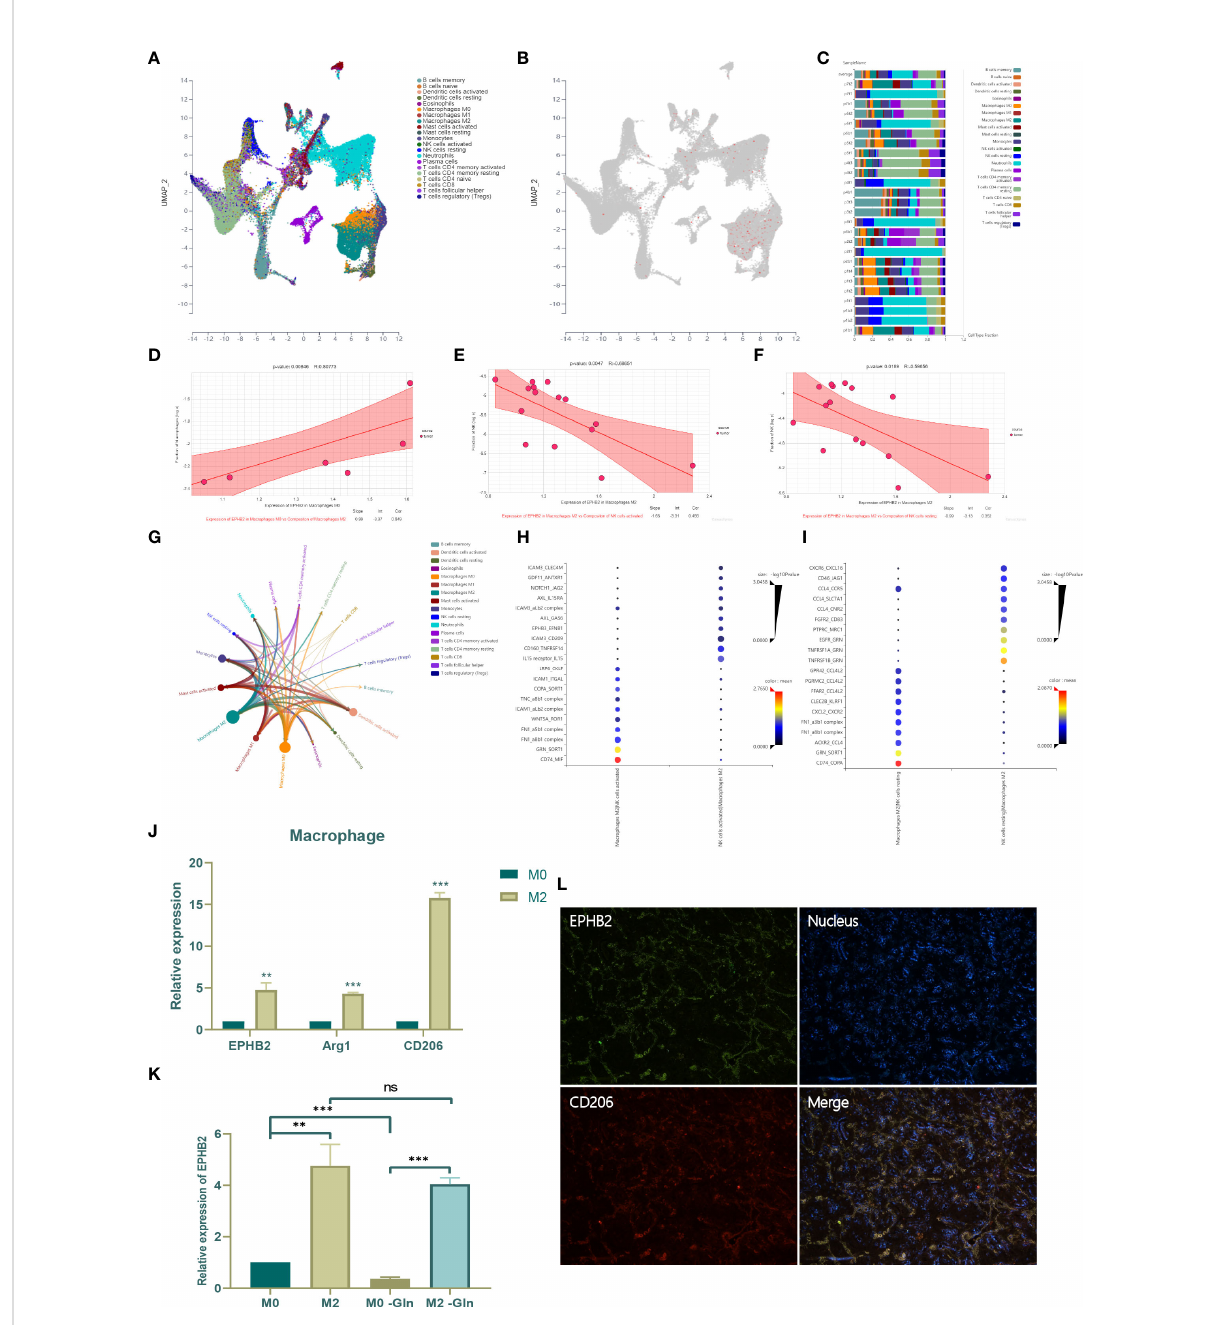
FIGURE 14 Effect of EPHB2 on in fi ltrating immune cells of TME. (A) The distribution of immune cell clusters in UMAP plot. (B) The expression of EPHB2 in distinct clusters of immune cells. (C) Cell type fraction of each sample. (D) Correlation analysis between expression of EPHB2 in macrophages M0 and composition of in fi ltrating macrophages M2. Correlation analysis between expression of EPHB2 in macrophages M2 and composition of in fi ltrating activated NK cells (E) and resting NK cells (F) . (G) Correlation network between tumor in fi ltrating immune cells. (H) The ligand- receptor interaction between macrophages M2 and activated NK cells. (I) The ligand-receptor interaction between macrophages M2 and resting NK cells. (J) Expression of EPHB2 and macrophages M2 markers in macrophages M0 and M2. (K) Expression of EPHB2 in normal macrophages M0, M2 and Gln-deprived macrophages M0, M2. (L) Co-localization between EPHB2 and CD206 detected by IF in LUAD specimen. “ ** ” means that p < 0.01; " “ *** ” means that p < 0.001; ns, no signi fi